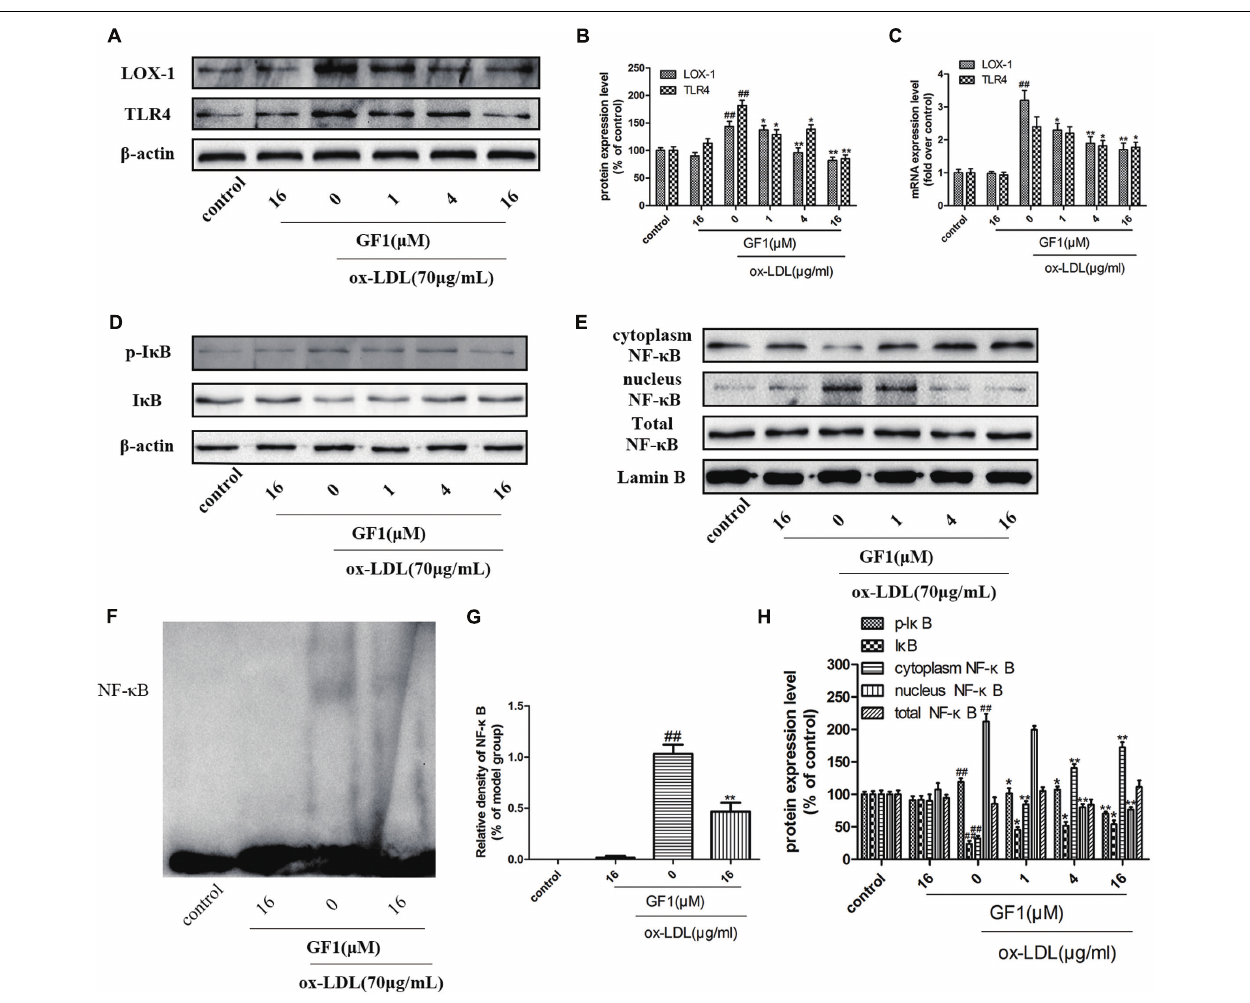
FIGURE 6 | Ginsenoside F1 suppressed LOX-1, TLR4, and blocked NF- κ B nuclear translocation in ox-LDL-treated HUVECs. HUVECs were pre-treated with various concentrations of GF1, followed by treatment with ox-LDL for another 24 h. (A) Protein expression levels of LOX-1 and TLR4 were measured via western blotting. (B) Densitometric analysis was used to quantify the levels of LOX-1 and TLR4. (C) Gene expression levels of LOX-1 and TLR4 were measured via real-time PCR. (D,E) Protein expression levels of p-I κ B, I κ B, cytoplasm NF- κ B, nucleus NF-Kb, total NF- κ B, β -actin and Lamin B were measured via western blotting. (F) Representative image of NF- κ B activation was evaluated using electrophoretic mobility shift assay. (G) Densitometric analysis of NF- κ B activation. (H) Densitometric analysis was used to quantify the levels of p-I κ B, I κ B, cytoplasm NF- κ B, nucleus NF- κ B, and total NF- κ B. All of the results are expressed as the mean ± SD of three independent experiments. ## p < 0.01, vs. control group; ∗ p < 0.05, ∗∗ p < 0.01 vs. ox-LDL